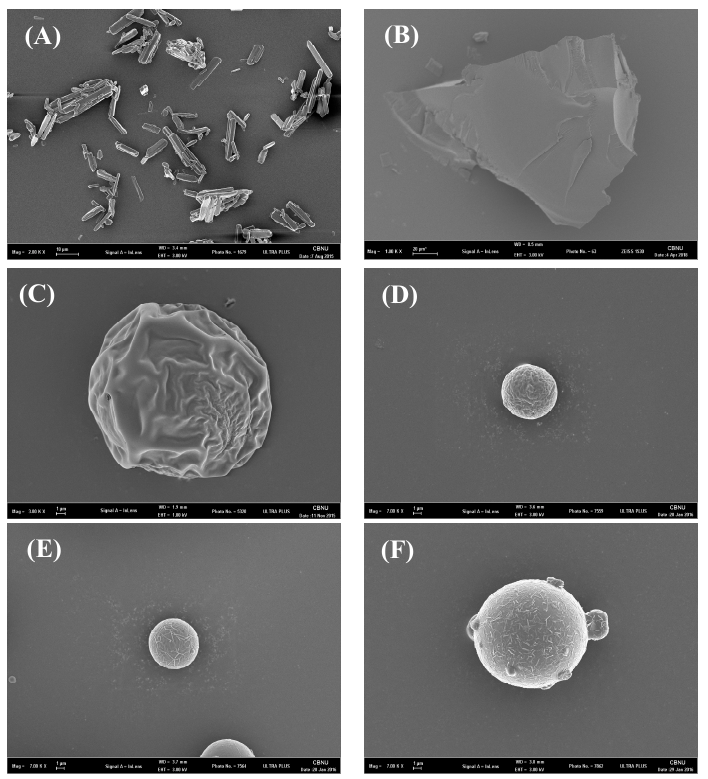
Figure 1. SEM images of ( A ) lacosamide ( × 2000), ( B ) Eudragit E100 ( × 1000), ( C ) spray-dried Eudragit E100 ( × 3000), ( D ) LCM-E100 (3:1) ( × 7000), ( E ) LCM-E100 (1:1) ( × 7000), and ( F ) LCM-E100 (1:3) ( × Table 2. Particle size distribution of lacosamide, LCM-E100 (3:1), LCM-E100 (1:1), and LCM-E100 (1:3). Formulations